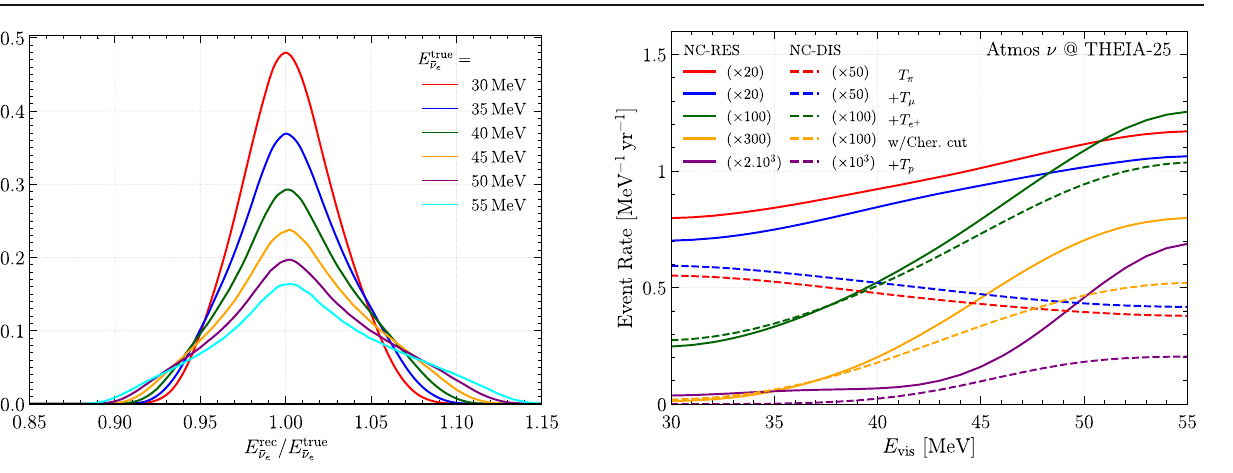
Fig. 5 The background event rate spectrum of the atmospheric NC- Fig. 4 The wrong scattering angle effect on the reconstructed neutrino RES (solid) and NC-DIS (dashed) events as a function of the visible energy E rec ν for the atmospheric ¯ ν e background in the unit of the corre- energy E vis with one year running at THEIA-25. For comparison, the sponding true neutrino energy E true ν . Several typical neutrino energies, e depositedenergiesofpion( T π ,red),muon( + T μ ,blue),positron( + T e + ) E true ν = 30MeV (red), 35MeV (blue), 40MeV (green), 45MeV (yel- e without (green) or with (yellow) Cherenkov cut, and proton ( + T p , pur- low), 50MeV (purple), and 55MeV (cyan), are shown for comparison ple) are added up step by step. To put all curves at similar heights, multiplication factors are implemented